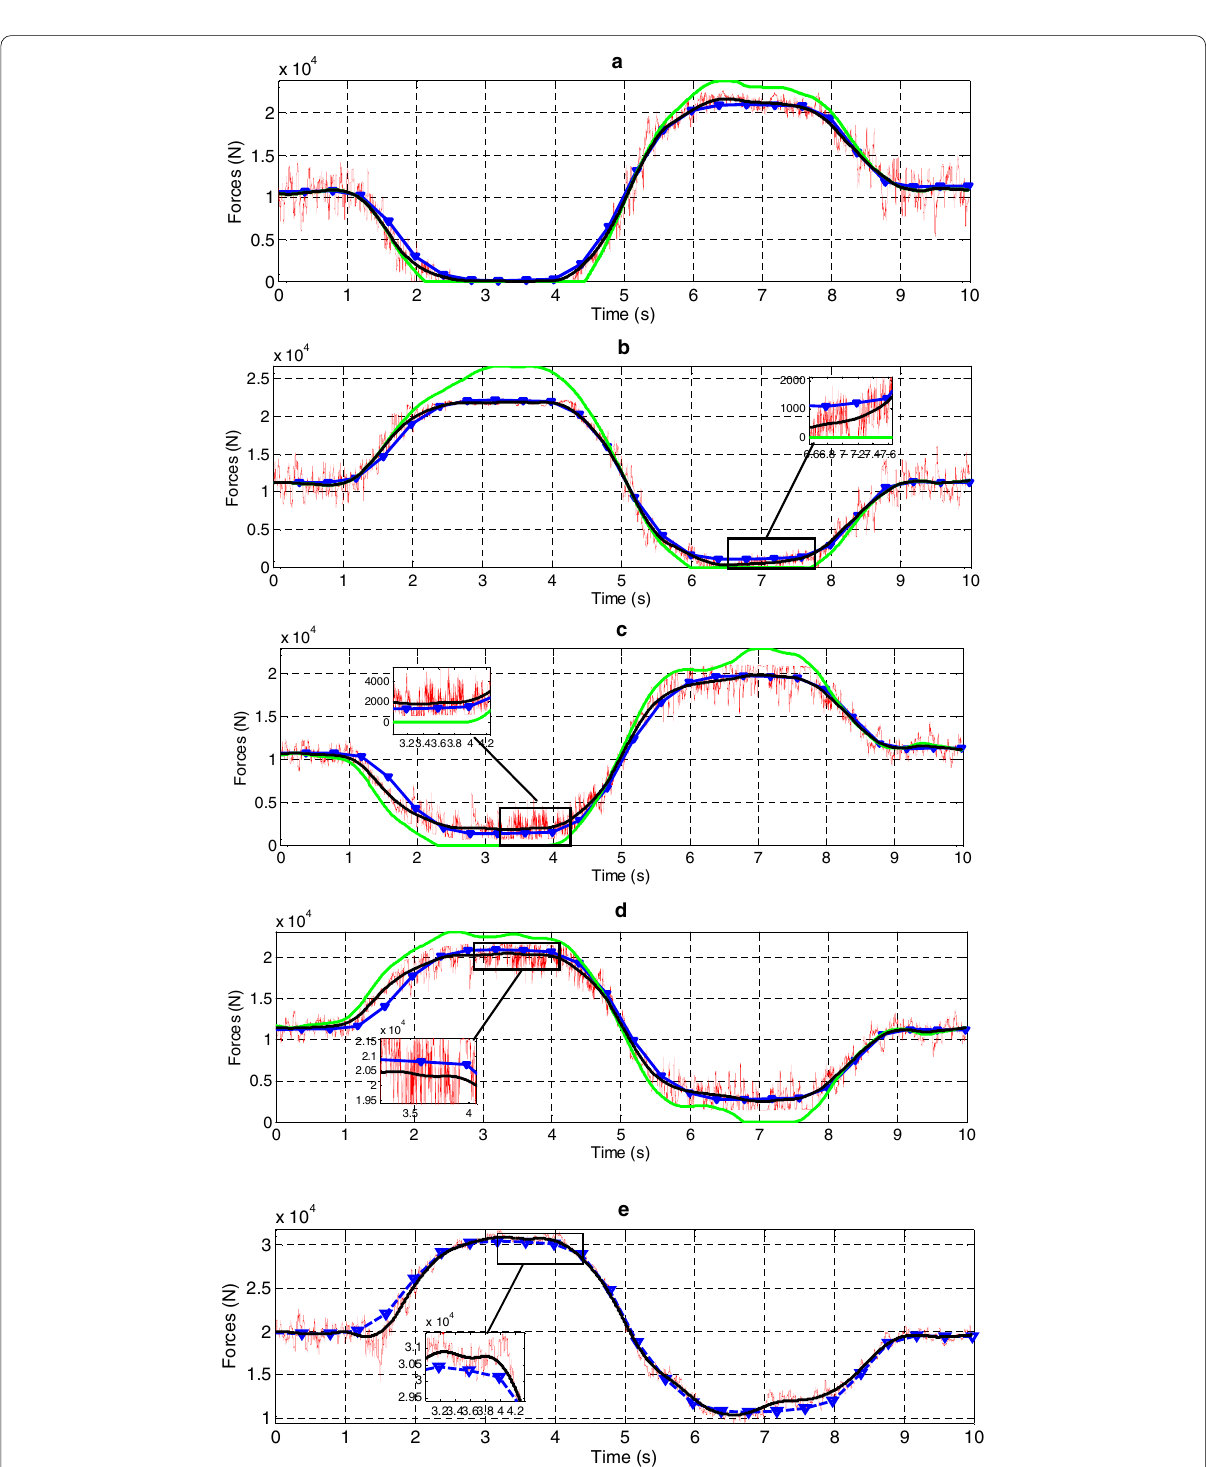
Figure 7 Comparisons between Trucksim and estimation under Condition